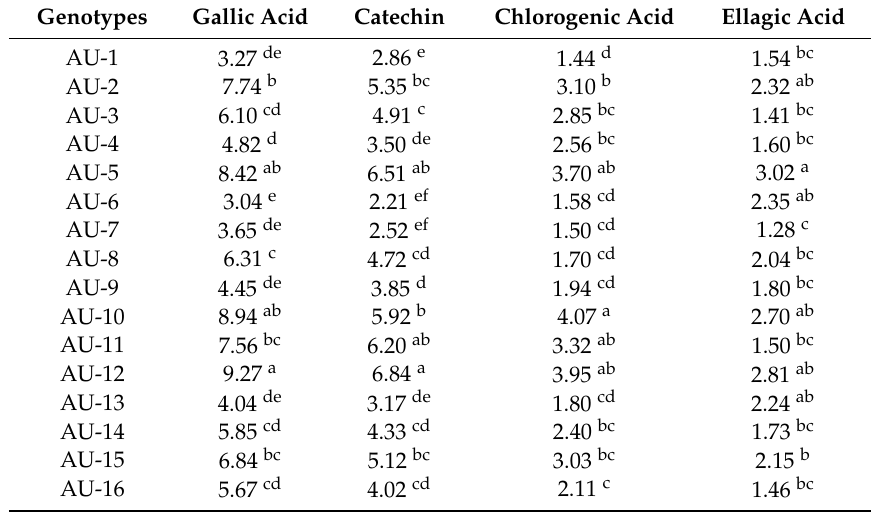
Table 6. Major phenolic acids of strawberry tree genotypes (average of 2017–2018 years) (mg / 100 g FW).